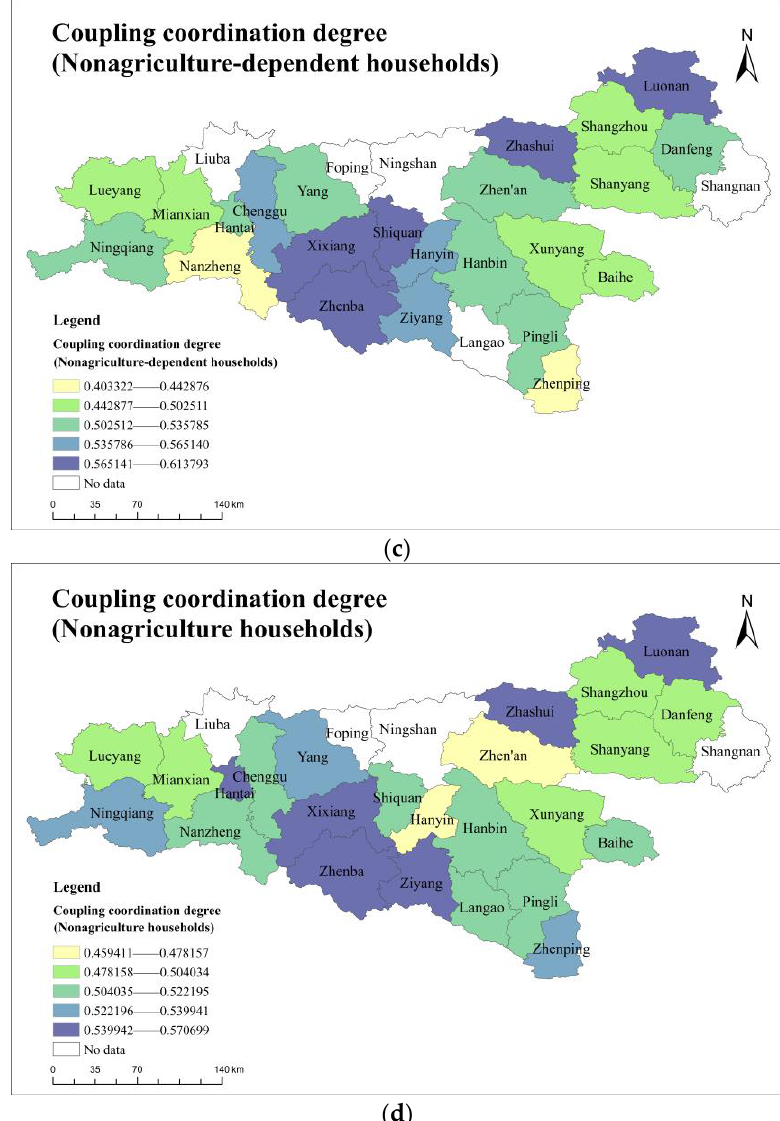
Figure 5. The spatial distribution of coupling coordination degrees of different types of households. Coupling coordination degree (pure-agriculture households) ( a ), coupling coordination degree (agriculture-dependent households) ( b ), coupling coordination degree (nonagriculture-dependent households) ( c ), coupling coordination degree (nonagriculture households) ( d ).